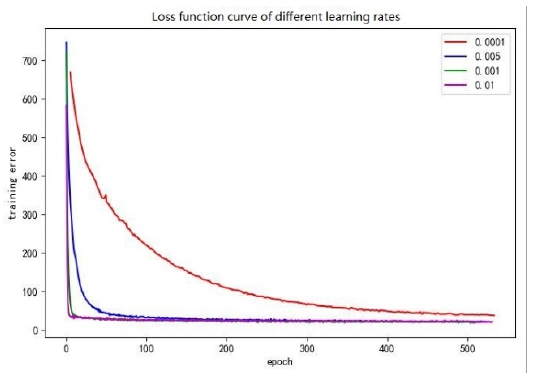
Figure 11. Loss function curve of the water detection model with different learning rates.